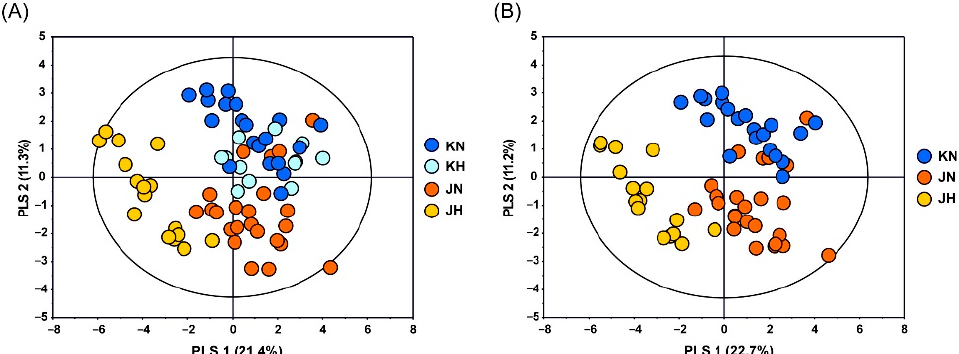
Figure 2. ( A ) PLS-DA score plot (R 2 X = 0.441, R 2 Y = 0.516, Q 2 = 0.356) of quantified metabolites in KN, JN, KH, and JH C. crenata chestnut show the pattern in which KH is included in KN. ( B ) PLS-DA score plot (R 2 X = 0.339, R 2 Y = 0.609, Q 2 = 0.521) of quantified metabolites shows the separation among KN, JN, and JH C. crenata chestnut. Letters on the legend represent: KN, Korean native or crossbred between Korean native; KH, Korean hybrid which crossbreeds with other origins; JN, Japanese native or crossbred between Japanese native; JH, Japanese hybrid which crossbreeds with other origins.